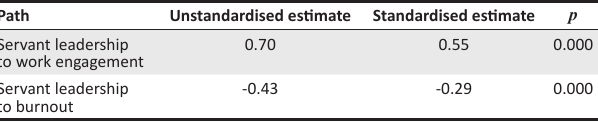
TABLE 6: The indirect effects of servant leadership on work engagement and burnout via job resources. Path Unstandardised estimate Standardised